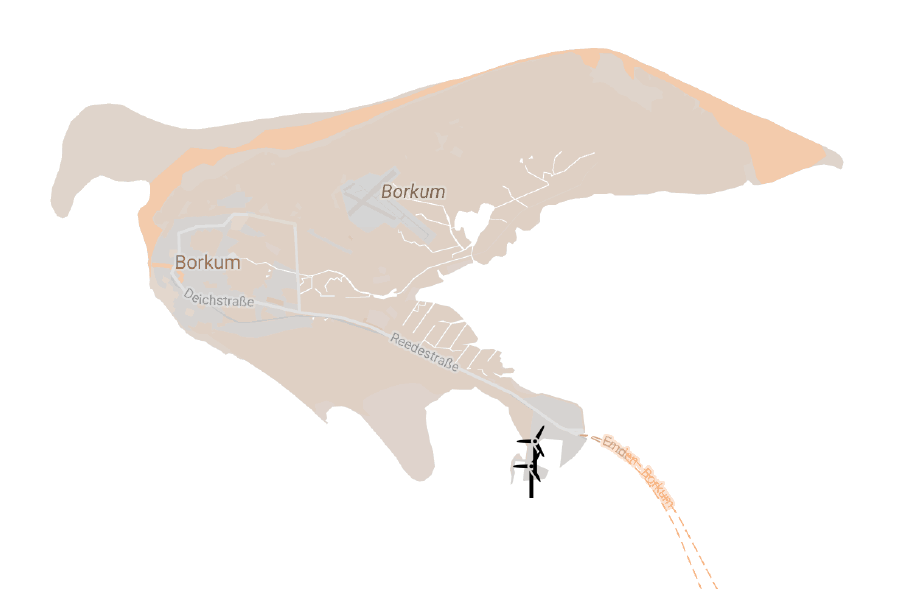
Figure 1. Location of the two wind turbine on the island of Borkum in Germany. The island is almost flat and the two turbines are about 400 m apart, installed at an altitude of 7 m above sea